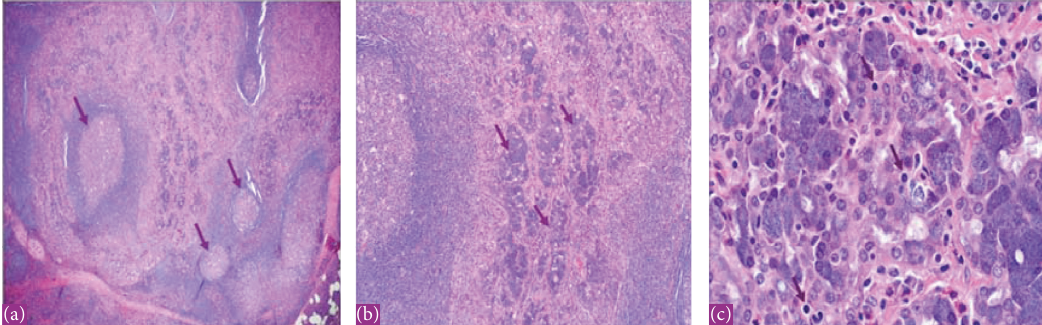
Figure 7: The histopathology with hematoxylin and eosin (H&E) stain showing acinic cell carcinoma with lymphoid background of the left parotid gland in 2020. (a) Low power showing lymphoid-rich stroma. (b) Medium power showing tumor with acini and granular cytoplasm. (c) High power x60 showing the basophilic granular cytoplasm (zymogen granules of neoplastic serous acini). The same tumor occurred metachronously in the left parotid gland.